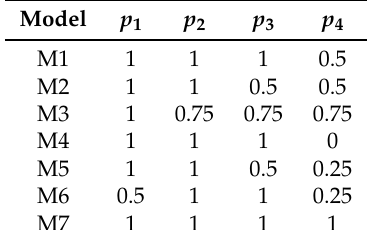
Table 2. The probabilities p i used to generate the models M1, M2, M3, M4, M5 and M6 in Figure 2.